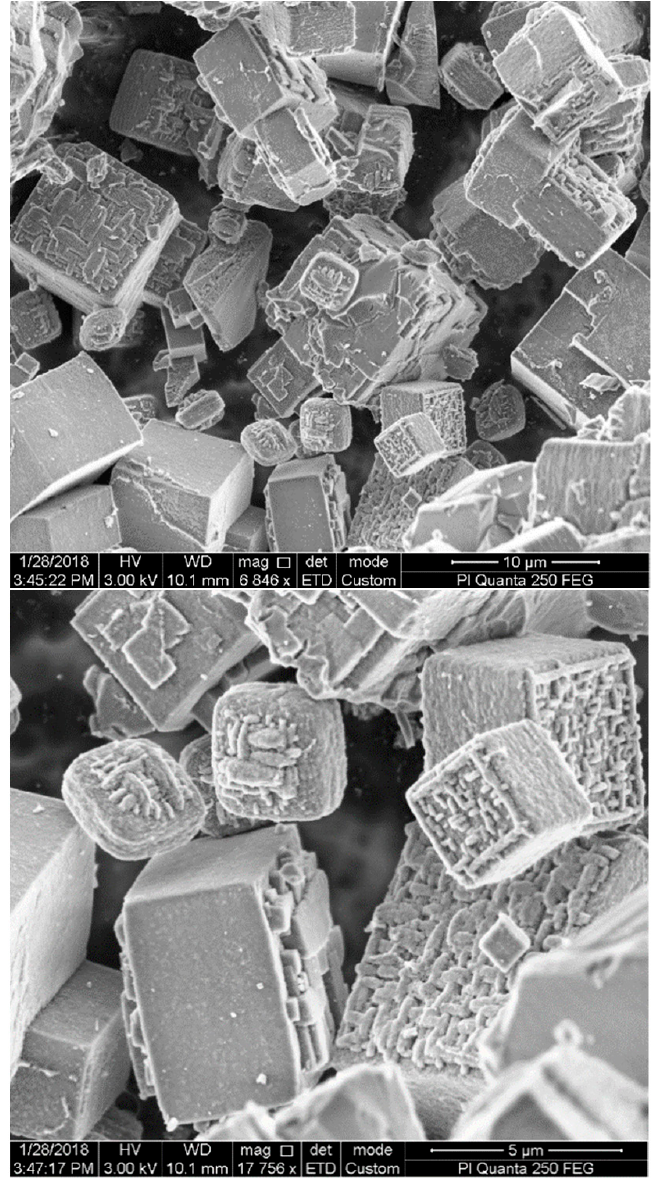
Figure 4. SEM image of SAPO-34 zeolite.